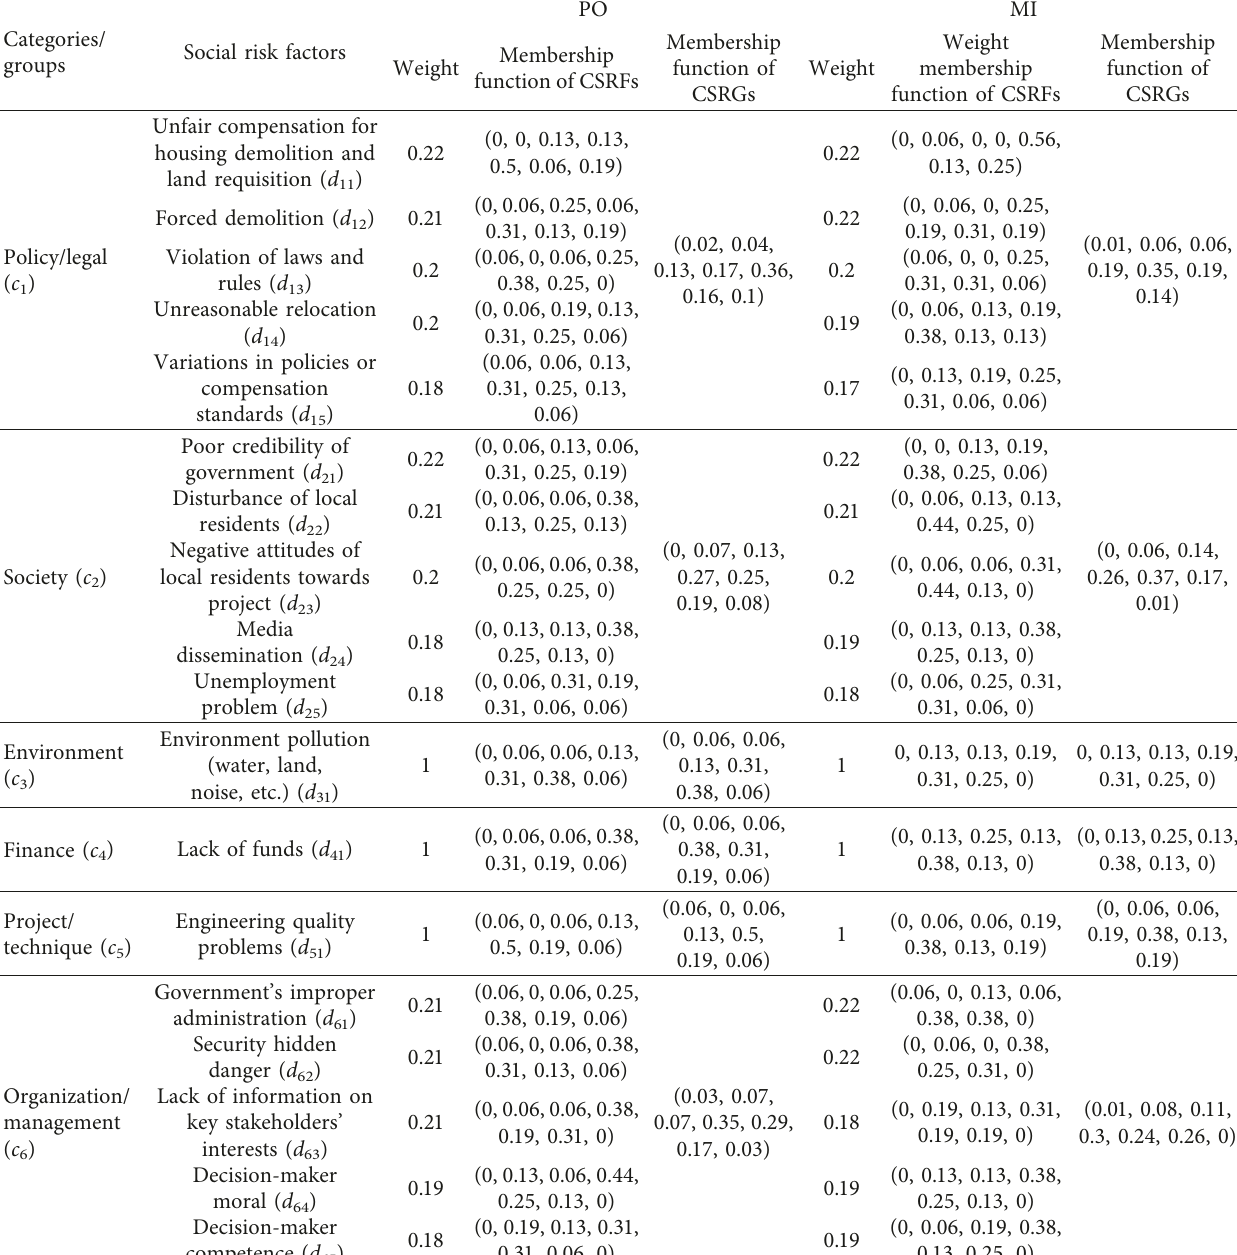
Table 6: Membership function of CSRFs and CSRGs for PO and